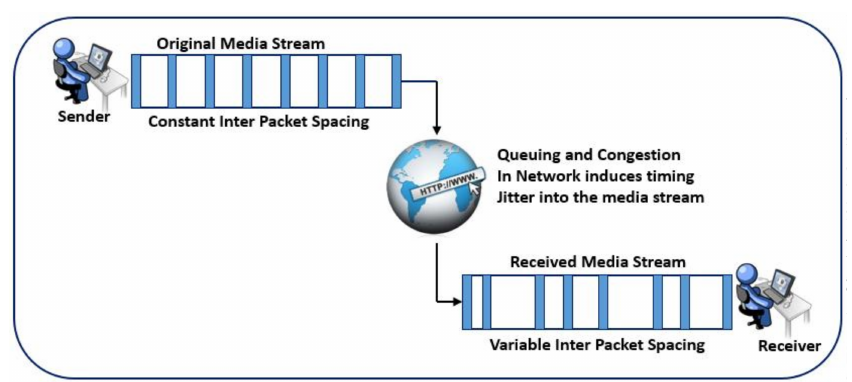
Figure 1. Disruption of inter-packet timing during Network Transit.